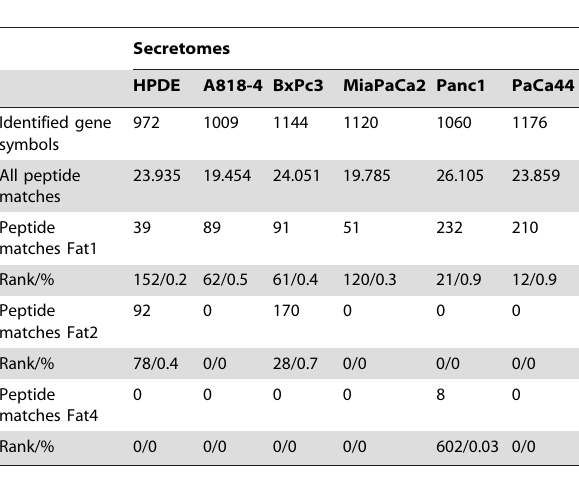
Abundance of Fat1 derived peptides in the secretome fraction of five pancreatic cancer cell lines (A818-4, BxPc3, MiaPaCa2, Panc1, PaCa44) compared to normal